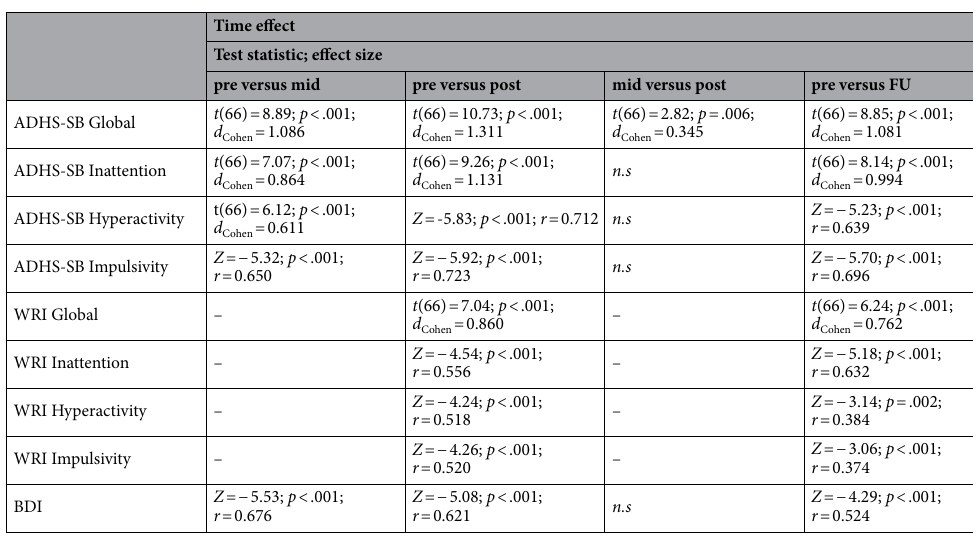
Table 3. Post-hoc analyses of symptom ratings before feedback training, after half of the sessions, after feedback training and at 6-months follow-up for each group. Note: Only significant post-hoc results are reported. ADHS‑SB = German ADHD self-rating scale for symptoms in adulthood 35,36 ; BDI = Beck-Depression Inventory 47 ; EMG = Electromyography; d Cohen = effect size Cohen’s d; FU = Follow-up; n.s . = not significant; SCP = Slow Cortical Potential; SD = Standard Deviation; WRI = Wender-Reimherr-Interview 35,36 : assessment at pre-, post- and follow-up